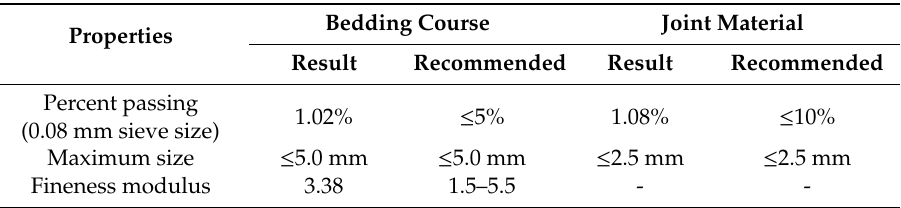
Table 3. Properties of sand for bedding course and joint material.